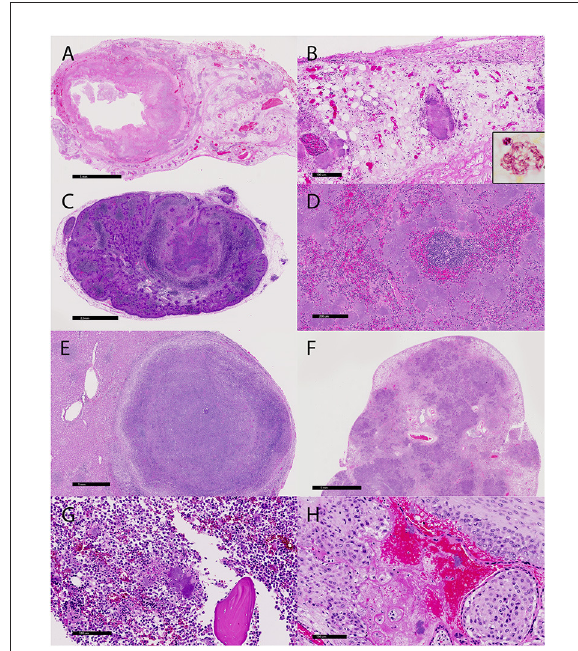
FIGURE2 Microscopic lesions associated with the yersiniosis epizootic, vervets, multiple organs. (A) Colitis, colon, case 3. The colonic wall is transmurally necrotic and expanded by inflammatory cells. Large colonies of bacilli extend into lymphatic vessels and the adjacent mesentery. HE. (B) Colon, case 3. Large colonies of bacilli are present in the mesentery. Inset: A colony of Gram-negative bacilli within the necrotic debris. Gram histochemical stain. (C) Lymphadenitis, mesenteric lymph node, case 18. Large bacterial colonies and necrotic debris efface the normal lymph node architecture. HE. (D) Splenitis, spleen, case 5. Colonies of 1x5 µ m bacilli largely obliterate the red pulp. (E) Hepatitis, liver, case 19. A well-demarcated abscess effaces the parenchyma. HE. (F) Pneumonia, lung, case 1. The lung architecture is extensively obscured by adjoining regions of bacteria, inflammation, and necrosis. HE. (G) Osteomyelitis, femur, case 18. Large colonies of bacteria, degenerate neutrophils, and cellular debris surround a fragment of necrotic bone in the medullary cavity. HE. (H) Placentitis, placenta, case 20. Bacteria and neutrophils infiltrate the decidua and maternal sinusoids.